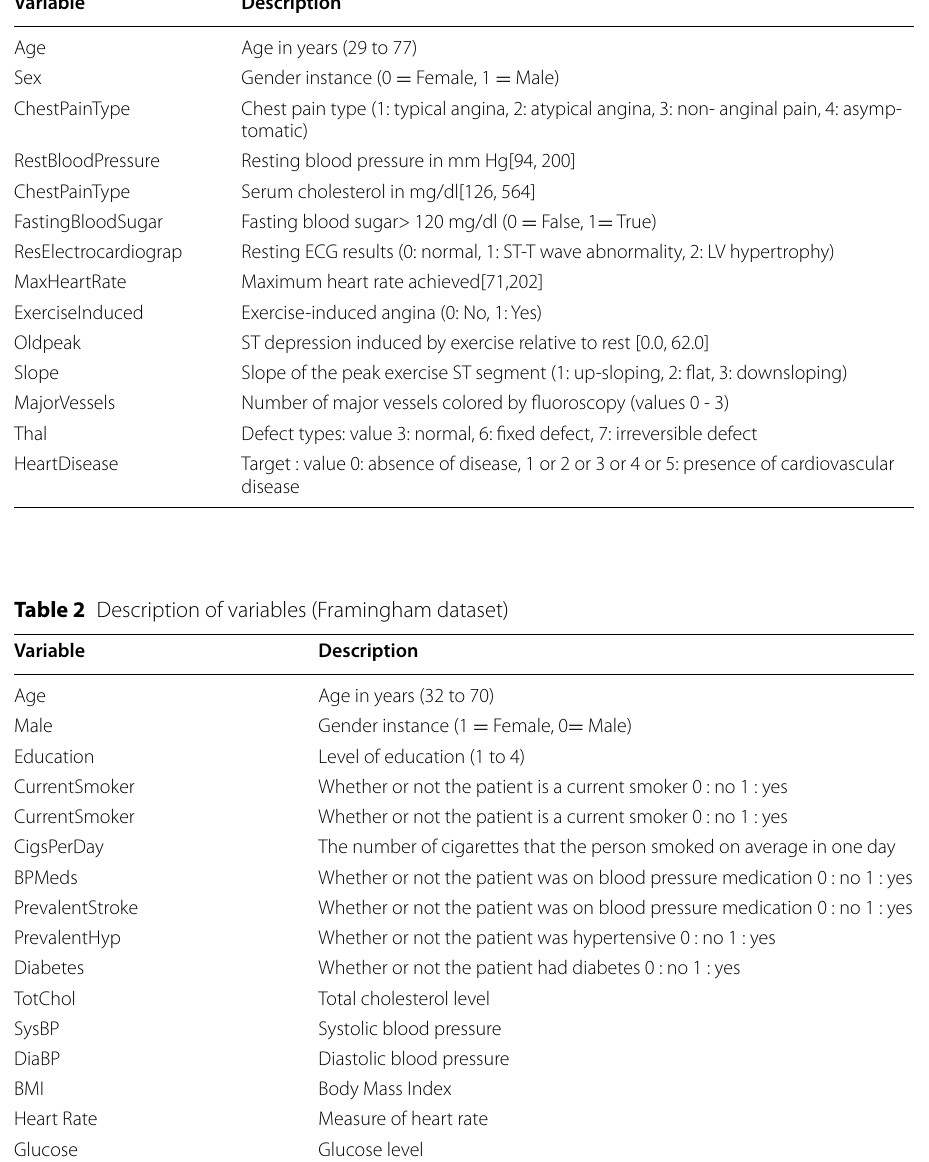
Table 1 Description of variables UCI heart dataset Variable Description